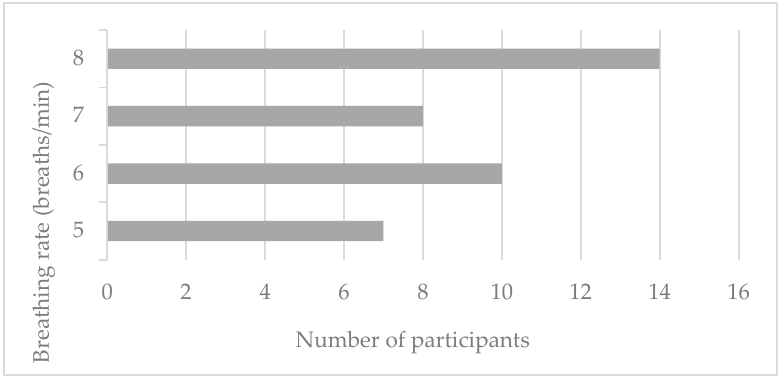
Figure 1. Distribution of the most suitable breathing rate in the study group.